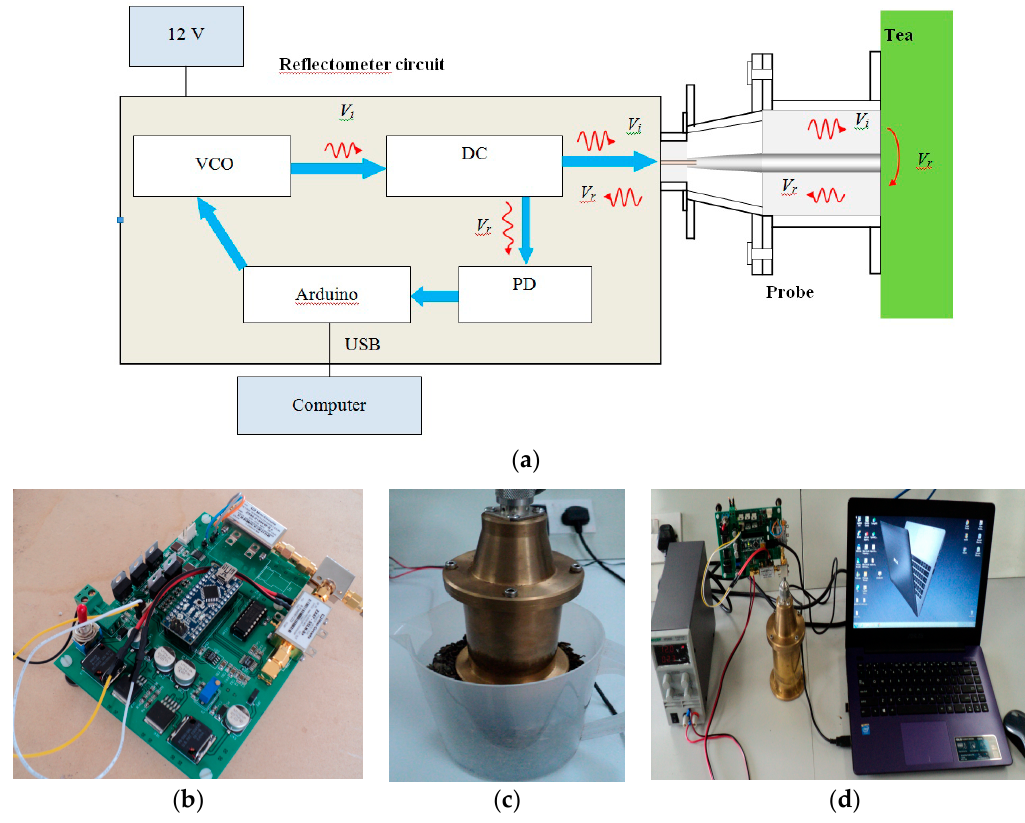
Figure 2. ( a ) Reflectometer-probe system diagram. ( b ) Reflectometer’s circuit. ( c ) Coaxial probe for tea leaves bulk measurements. ( d ) Overall measurement system.